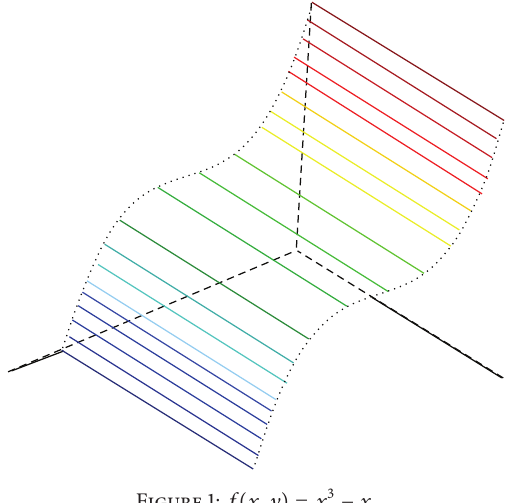
Figure 1: 𝑓(𝑥,𝑦) = 𝑥 3 − 𝑥 .